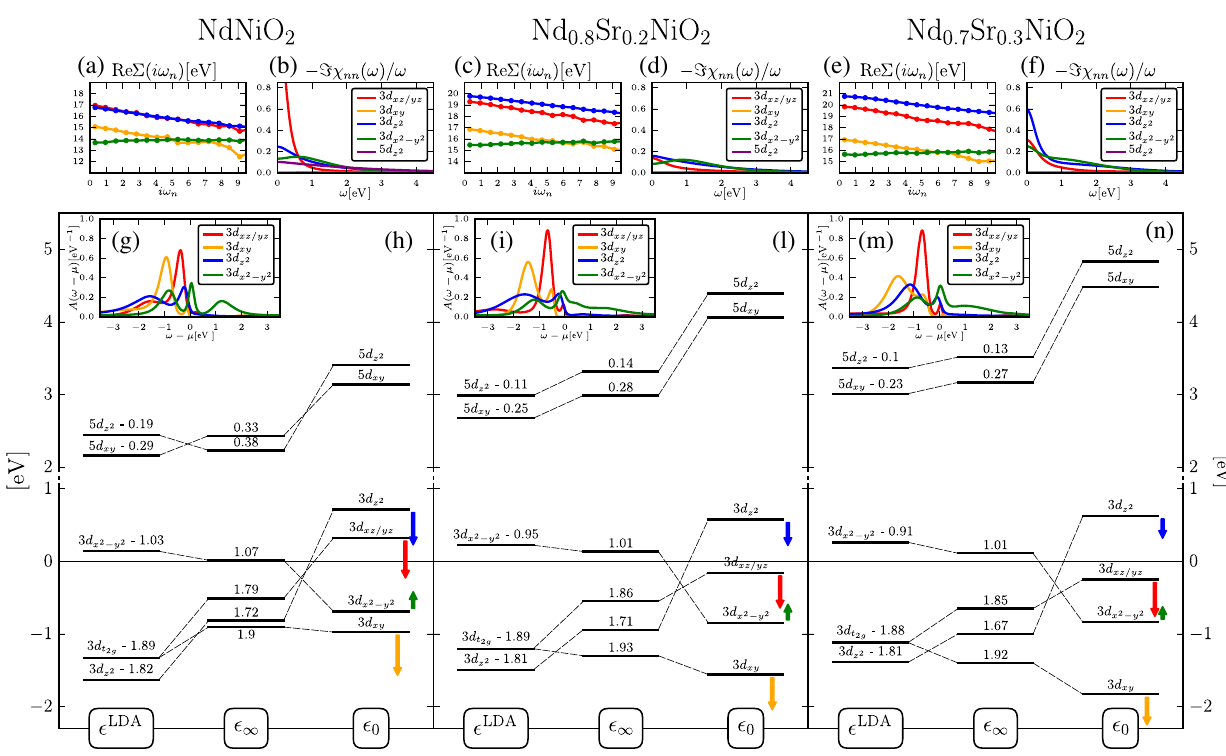
FIG. 3. Level diagrams and energy-dependent shifts of the accessible states. The results for the indicated dopings are summarized in the main panels (h), (l), and (n). The level diagrams on the left, marked with ϵ LDA , show the average energies of the LDA bands. The level diagrams in the middle, marked ϵ ∞ , indicate the center of mass of the correlated density of states, which is plotted in panels (g), (i), and (m). The level diagrams on the right, marked ϵ 0 , indicate the level energies of the EDMFT impurity problems, shifted by 0 Þ . Energies are plotted relative to the chemical potential, and the numbers near the levels report the orbital occupations. To Re Σ ð ω n ¼ illustrate the effect of the ω dependence of the self-energy, shown in panels (a), (c), and (e), we illustrate with arrows the level shift n produced by increasing ω to 3 eV (except for the green arrow, where we used 10 eV for a better visualization of the shift direction). n Panels (b), (d), and (f) show the charge susceptibilities for different orbitals on the real-frequency